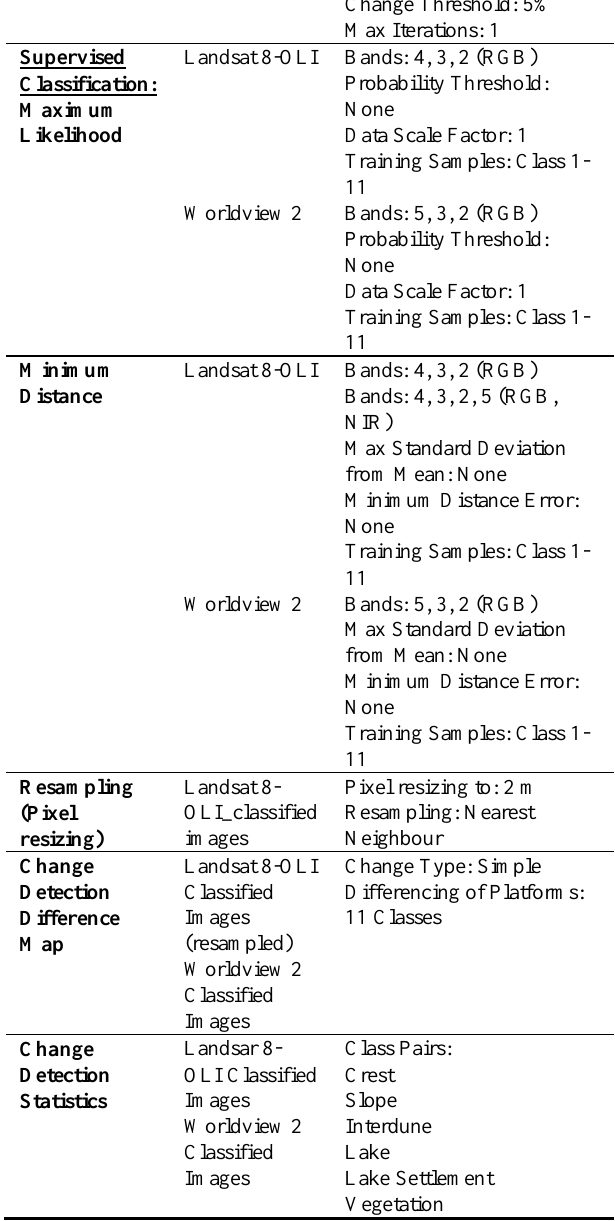
Table 3: Parameters used in image processing and classification.